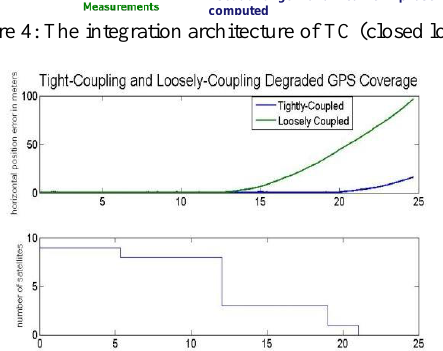
Figure 5: The comparison between TC and LC architectures with variable number of visible satellite